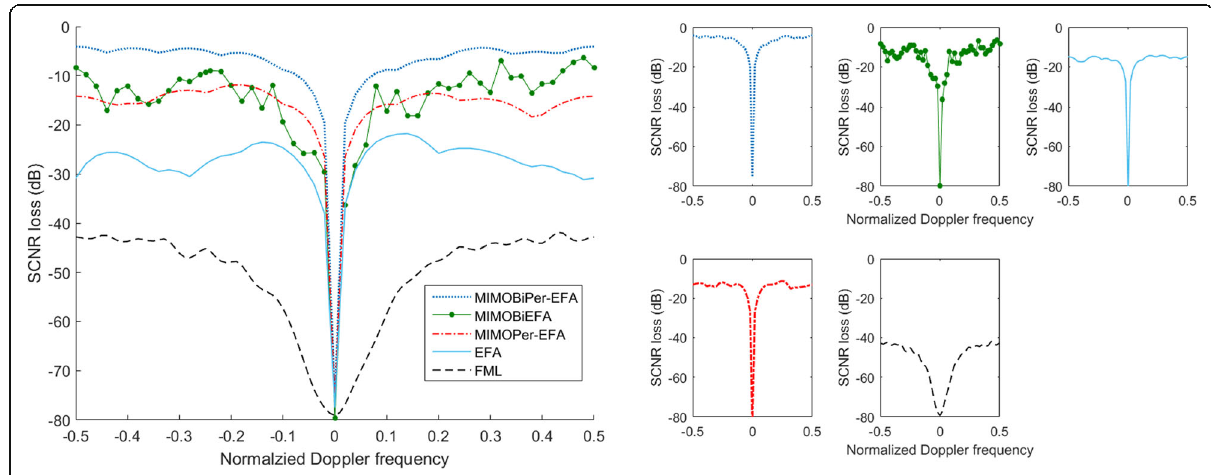
Fig. 6 SCNR loss curves with small training samples support under sidelooking scenario ( L = 20)